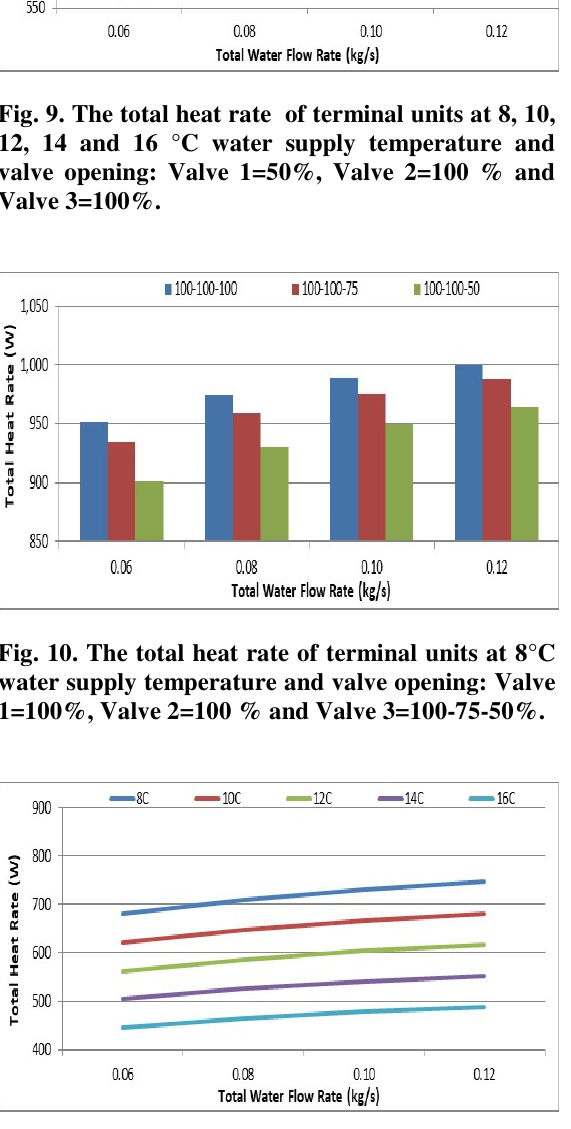
Fig. 8. The total heat rate of terminal units at 8, 10, 12, 14 and 16 °C water supply temperature and valve opening: Valve 1=75%, Valve 2=100 % and Valve 3=100%.